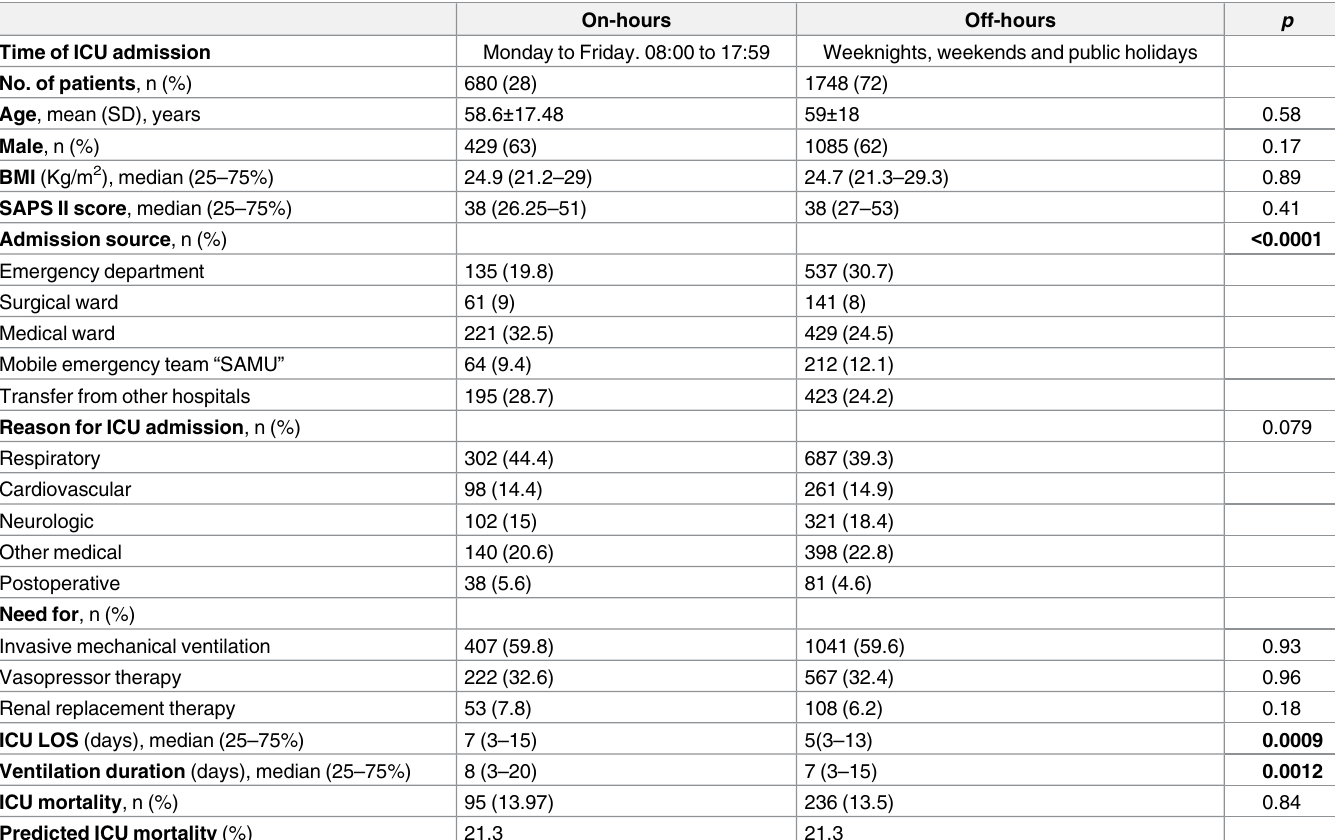
Table 2. Comparison of patients admitted during on-hours and off-hours. BMI: body mass index; SAPS II: simplifiedacute physiology score II; ICU: intensivecare unit; LOS: lengthof stay; “SAMU”: S erviced’ A ide M e´dicale U